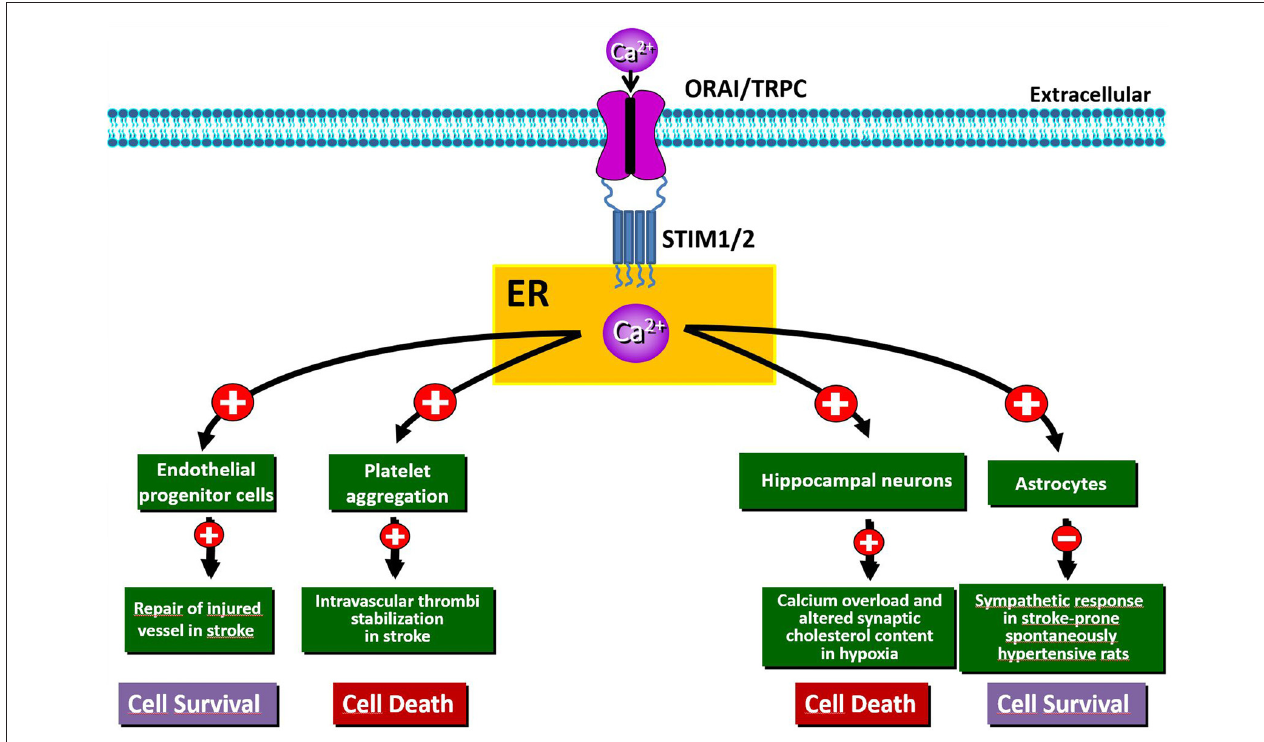
FIGURE 1 | Schematic representation of the beneficial and/or detrimental effects of store-operated Ca 2 + entry (SOCE) activation in different cell types involved in hypoxia/ischemia insult.